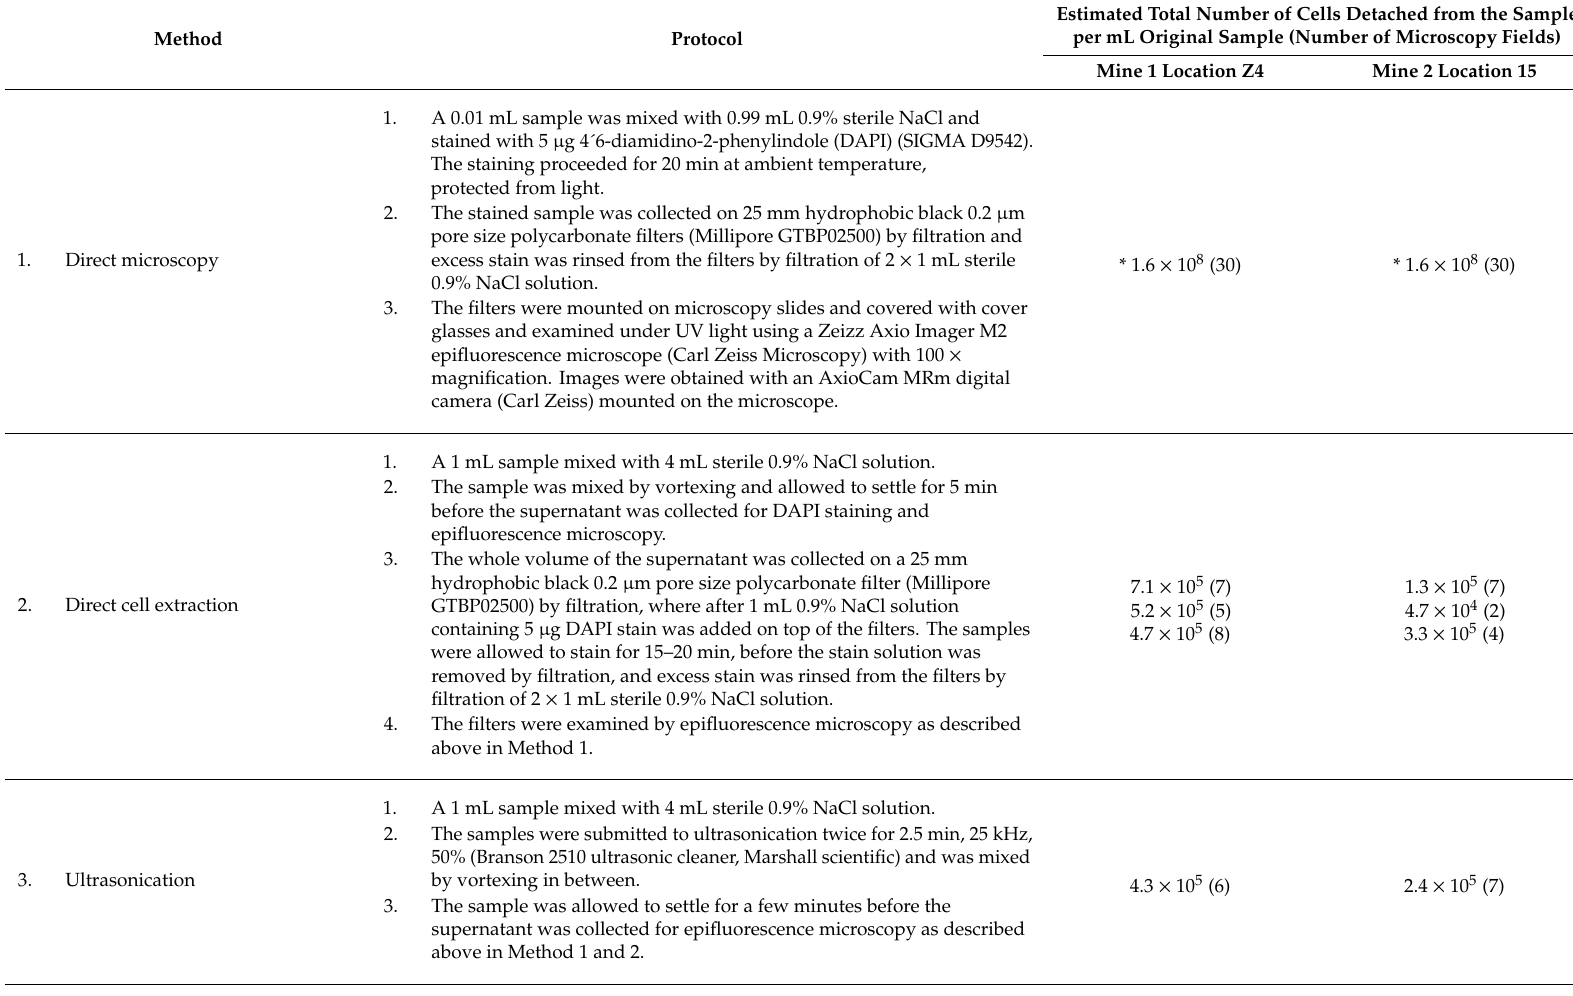
Table A5. The estimated number of microbial cells in the tested samples from Mine 1 (location Z4) and Mine 2 (location 15) and the e ffi ciency of di ff erent methods for cell detachment from the solid particles of samples from the same